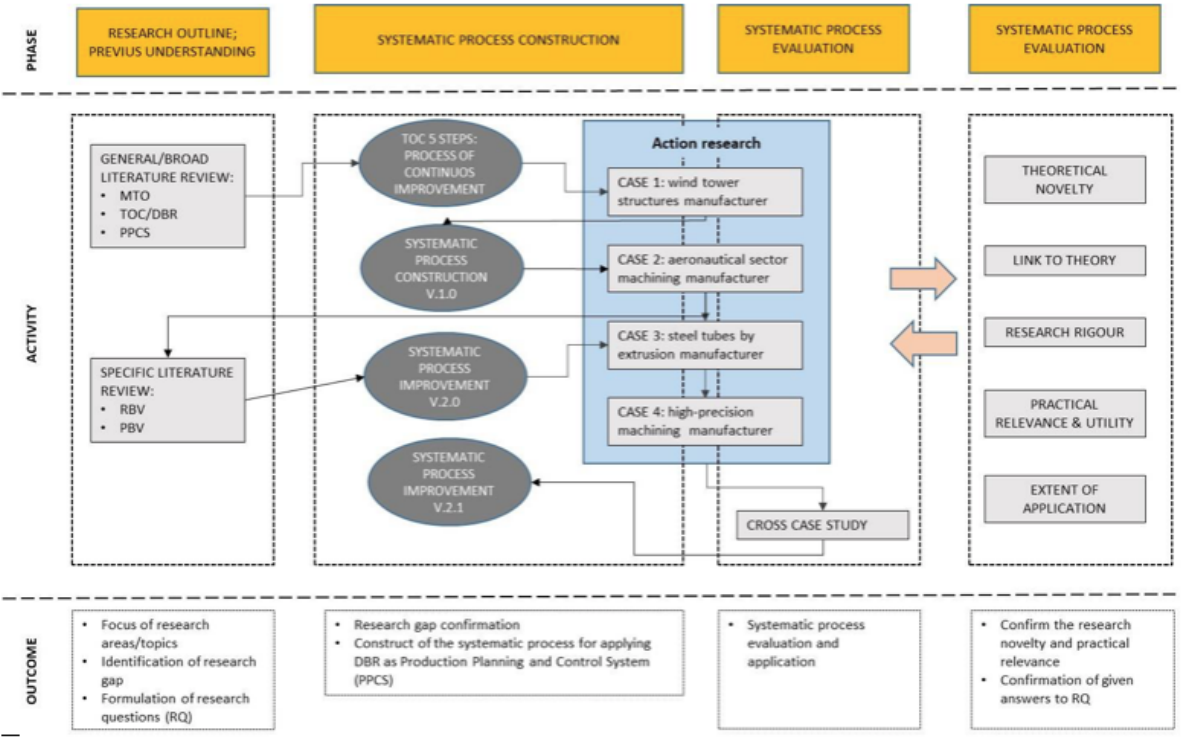
Figure 3. Research project